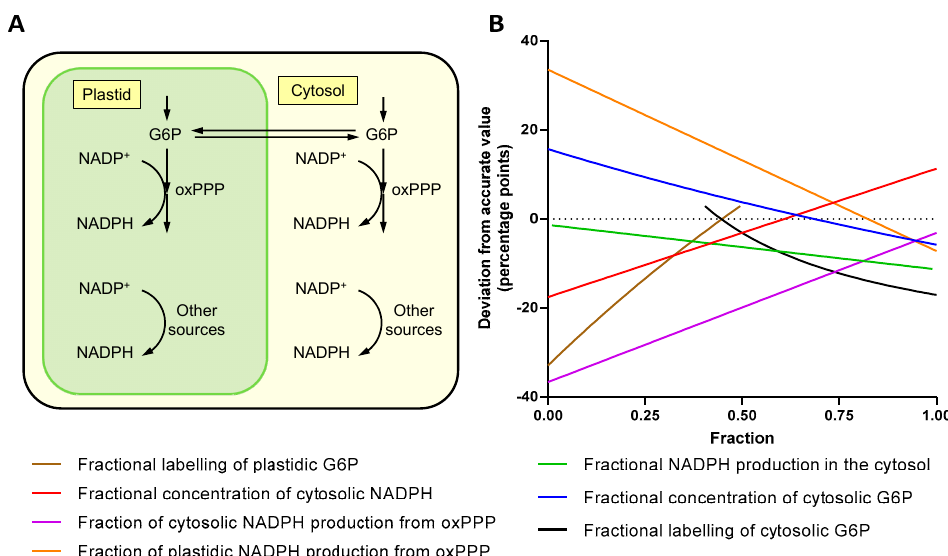
Figure 5. The effect of compartmentation on the measurement of the oxPPP contribution to total NADPH production. ( A ) Two compartment model simulating duplicated oxPPP in the cytosol and plastids. ( B ) The deviation of the experimentally measured value for a whole cell extract from the actual value for the oxPPP contribution to total cellular NADPH production. Each parameter was varied between 0 and 1 whilst all other parameters were fixed at the following values: fractional amount of cytosolic G6P, 0.85 [49]; fractional amount of cytosolic NADPH, 0.5 [50,51]; fractional NADPH production in the cytosol, 0.18 [29]; fraction of cytosolic NADPH production from oxPPP, 1.0 [29]; fraction of plastidic NADPH production from oxPPP, 0.9; fractional labelling of cytosolic G6P, 0.5; and fractional labelling of plastidic G6P, 0.4. The model was constructed using linear equations in MATLAB (see Supplementary Materials for link to